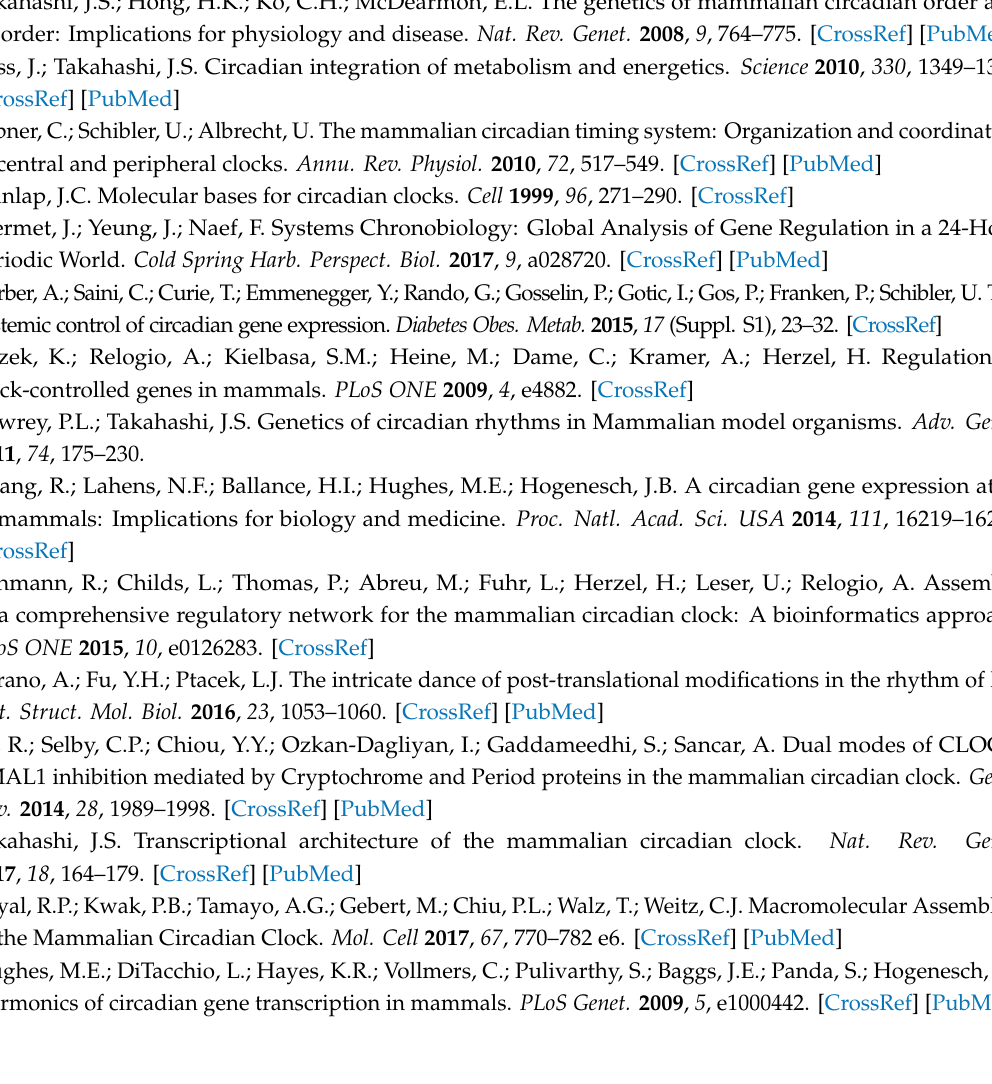
set. Table S7. Descriptive statistics for the data in Table 1. Table S8. Free energy ( ∆ G) terms included in the core function of FoldX, the empirical force field algorithm aiming to calculate the change of ∆ G in kcalmol − 1 . Table S9. Chromosome mapping of oscillating